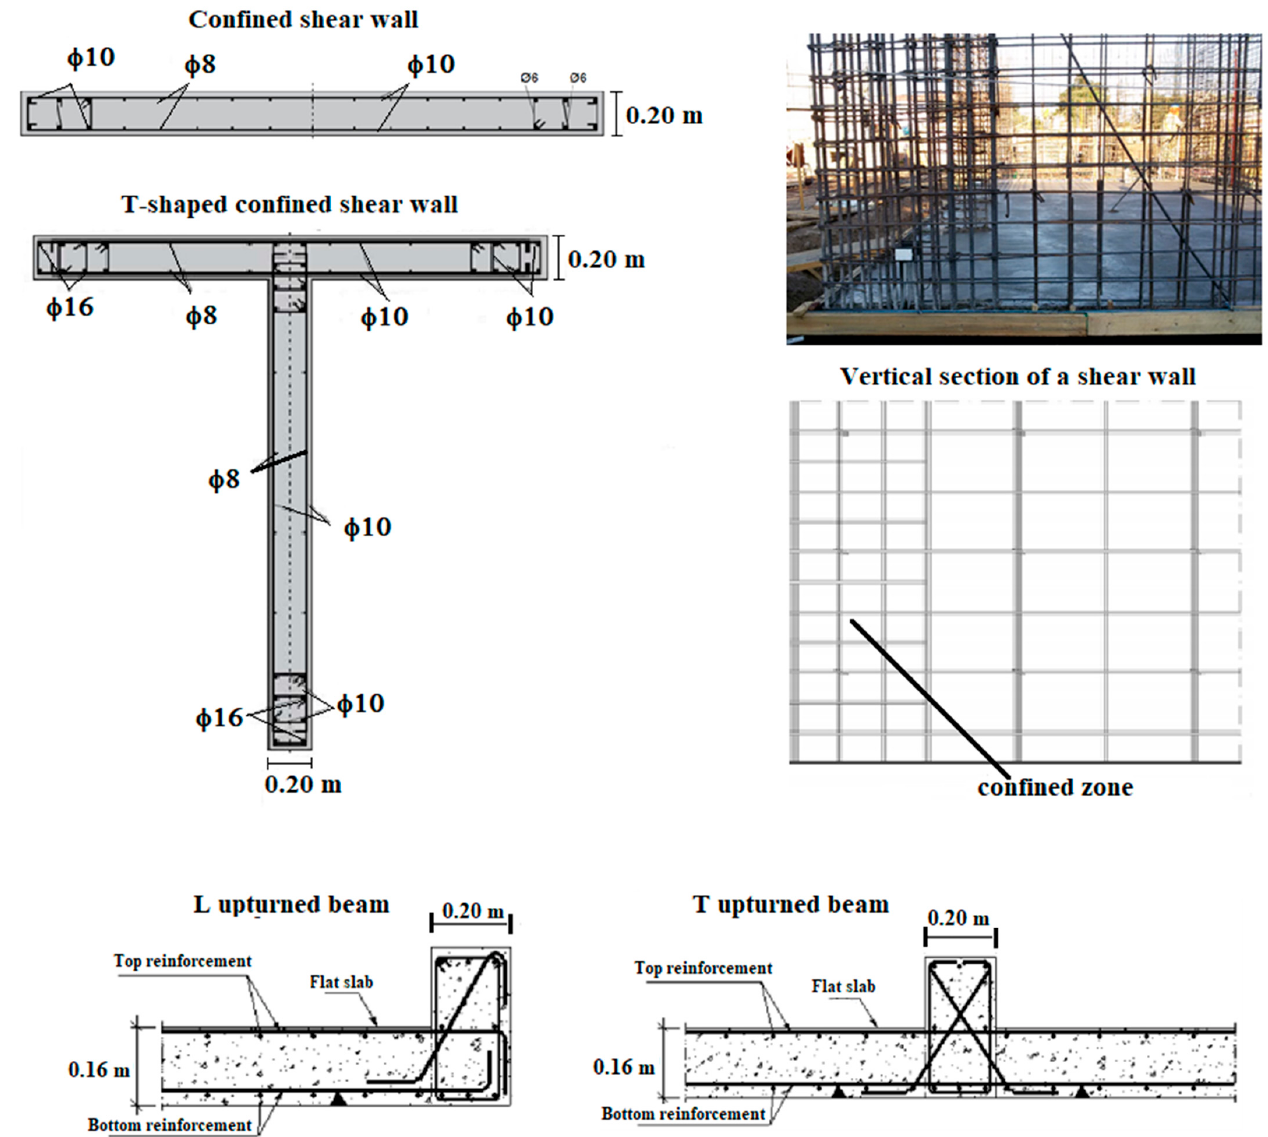
Table 2. Properties of reinforcement steel.